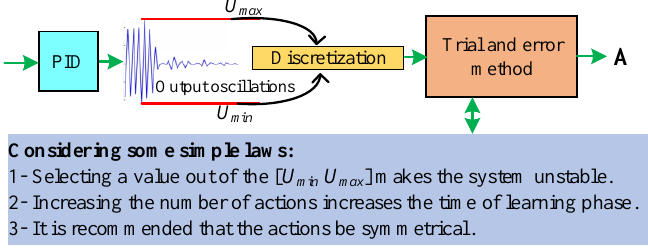
Figure 8. A simple description for generating the action